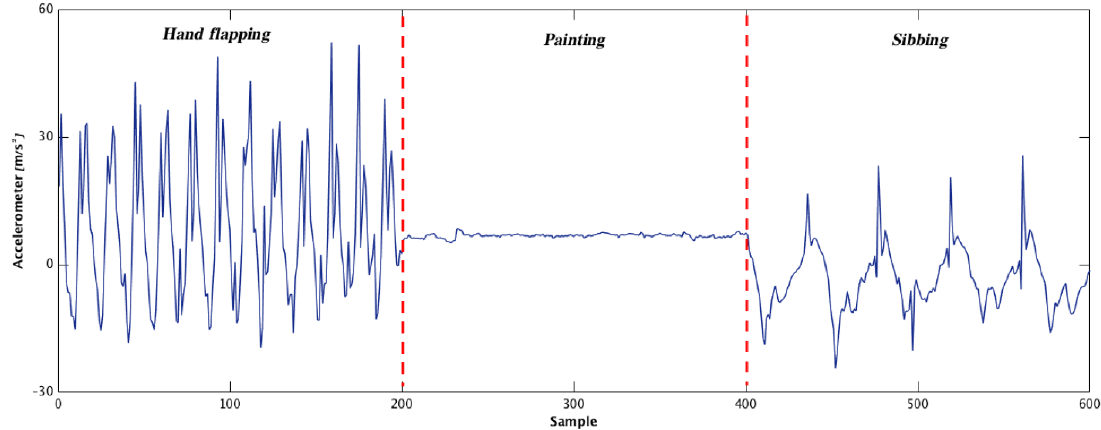
Figure 2. Illustration of Z-axis variation of the accelerometer for three